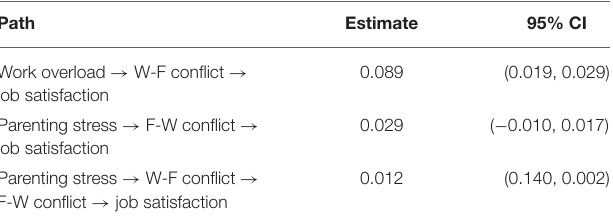
TABLE 2 | The bootstrap confidence interval and effect size of the mediation